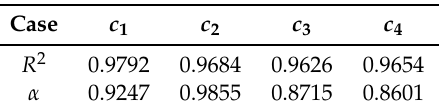
Table 2. MSD of average HA chain for abnormal case fit parameters. Symbols: c 1 = 0 (indicating